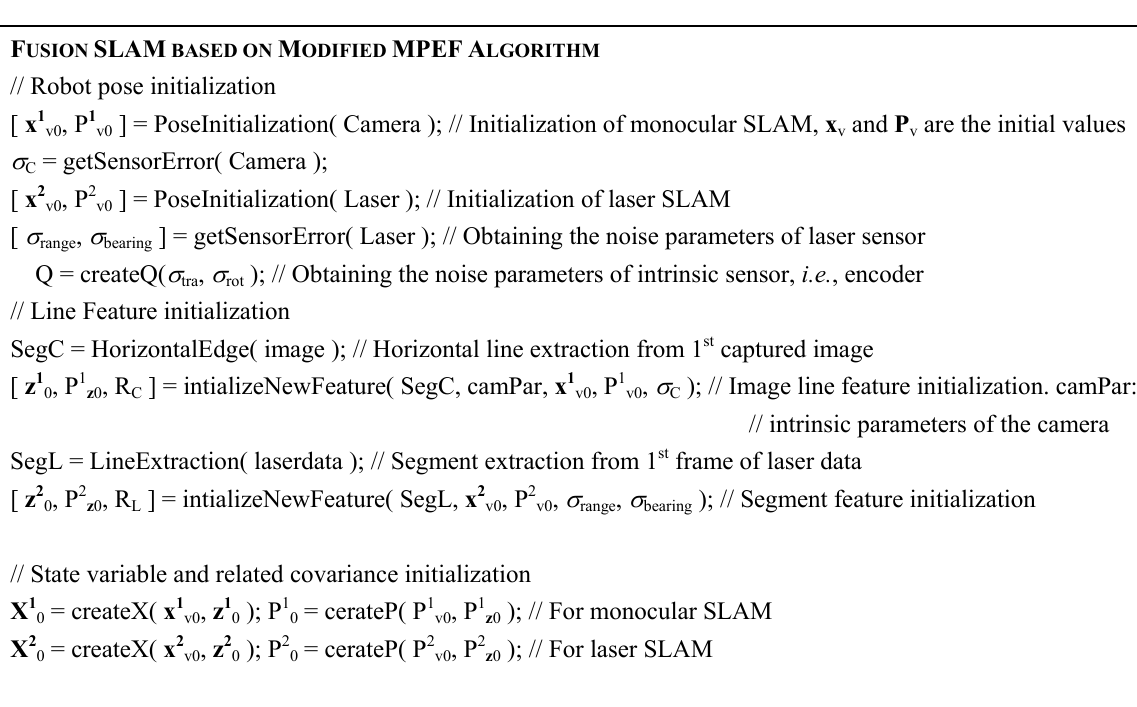
Algorithm 2. Modified MPEF-SLAM